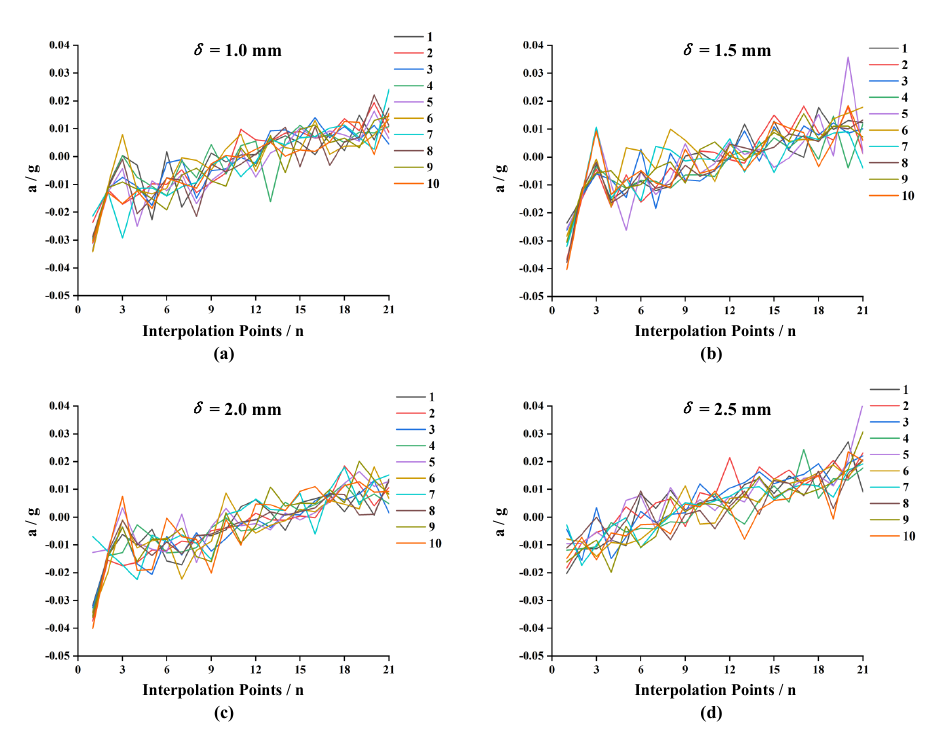
Figure 10. Statistics of the acceleration variation on the Z -axis, consisting of four sets of bark consumption settings.